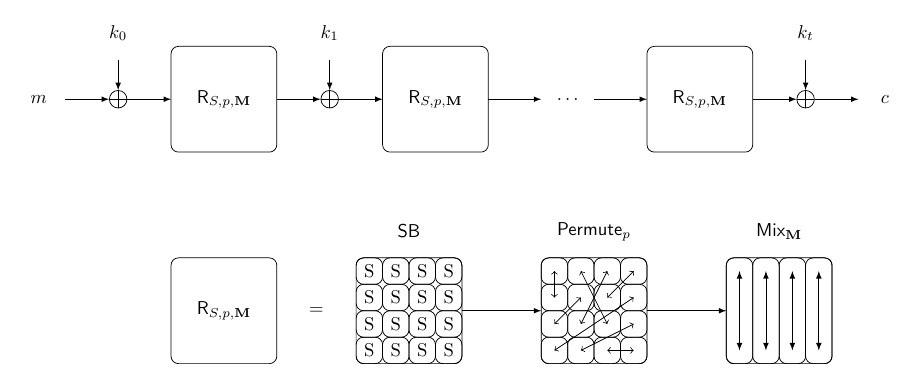
Figure 1: The iterative structure of a substitution-permutation cipher using an AES-like round for a 4 × 4